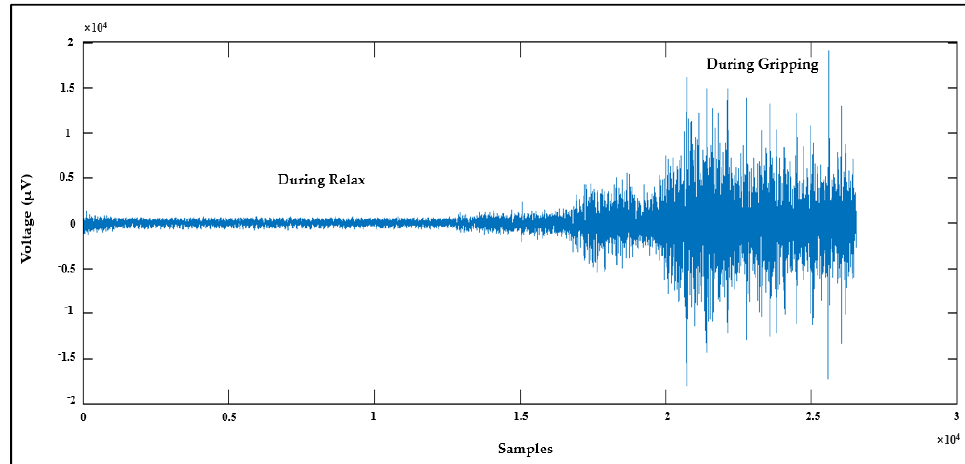
Figure 10. ECG signal collected using AFE.